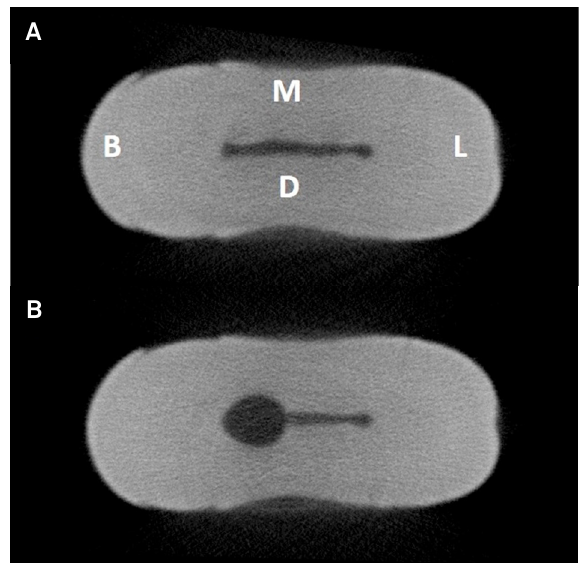
Figure 1. Root cross-sections of the middle third. A - Before instrumentation. B - After instrumentation. Root aspects: B, Buccal; L, Lingual; M, Mesial; D, Distal.